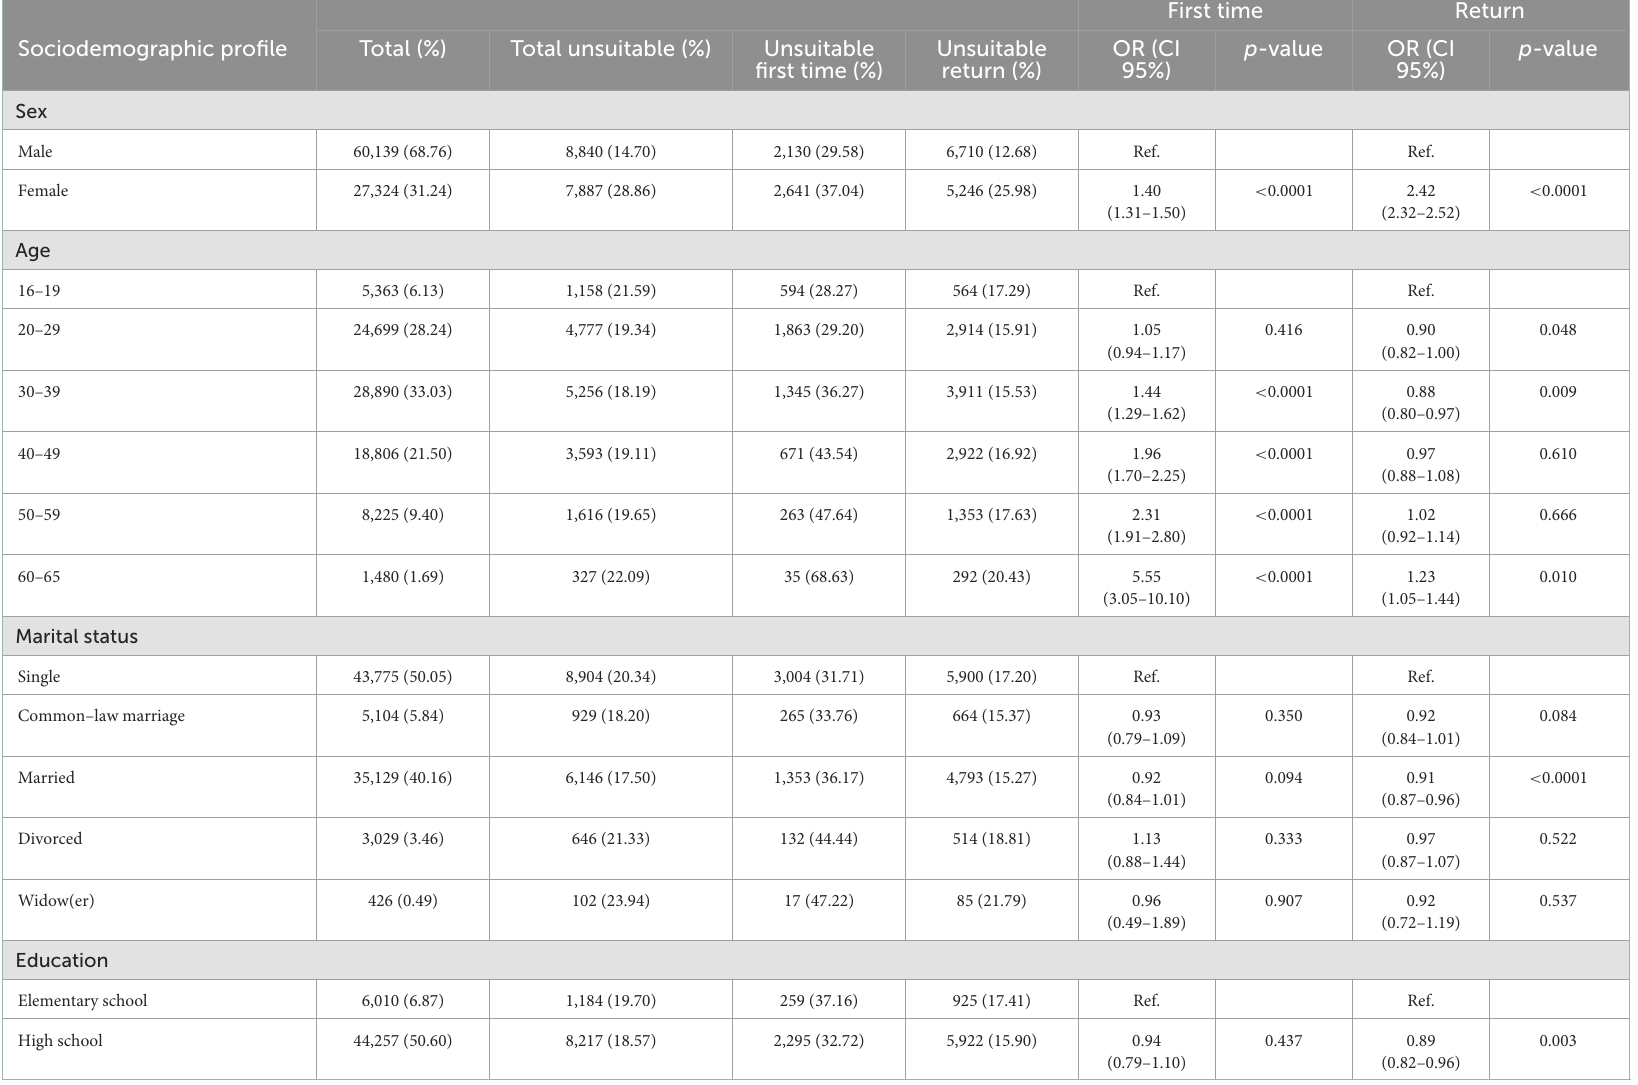
TABLE 1 Sociodemographic profile of unsuitable donors between the years